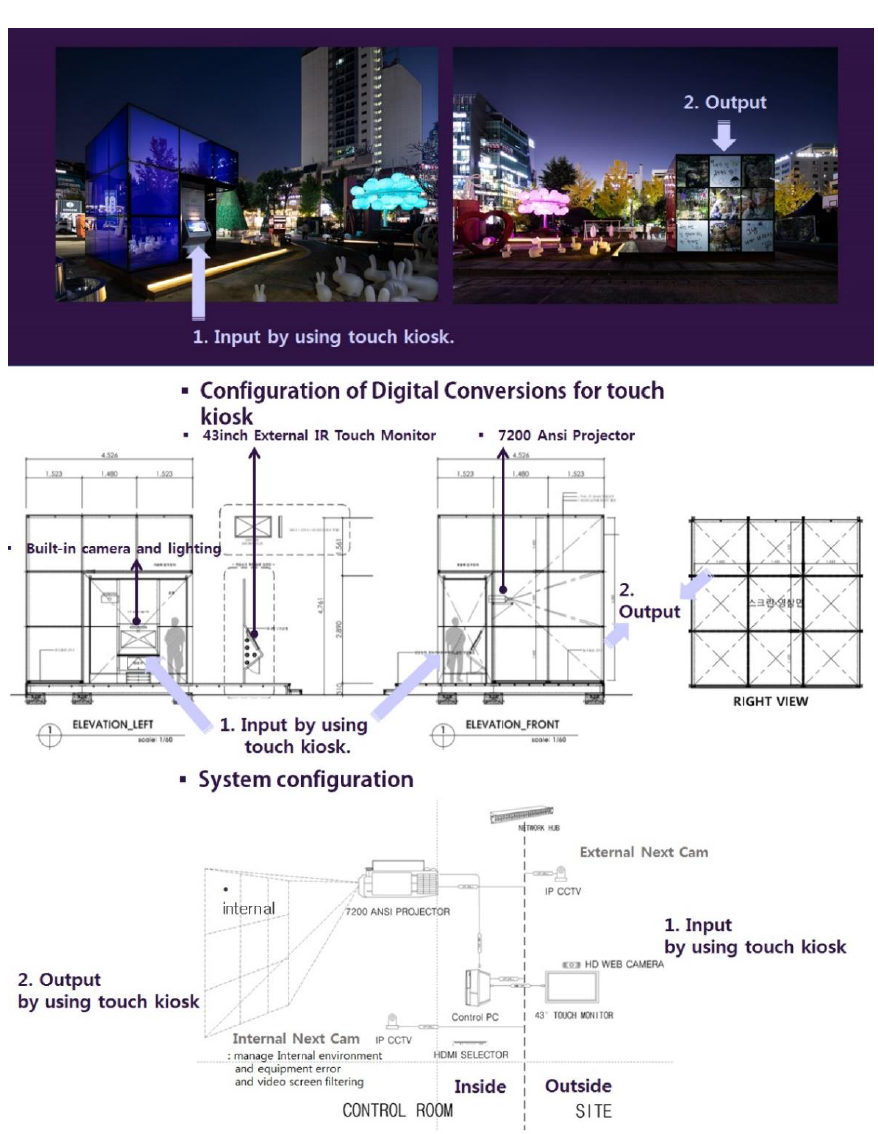
Figure 7. User engagement media-interaction plans for the “Dream Light Cube , ” project [18]: 1. With media interaction technology, users input photos or messages on the kiosk touch screen. The touch kiosk screen is a smartphone application concept system that anyone can use. 2. The content entered by the user is linked to one screen out of nine screens by a beam projector, and media is transmitted in a time-difference rotation on the large screen. Choi Kyubok, all rights reserved (photo in 2019).